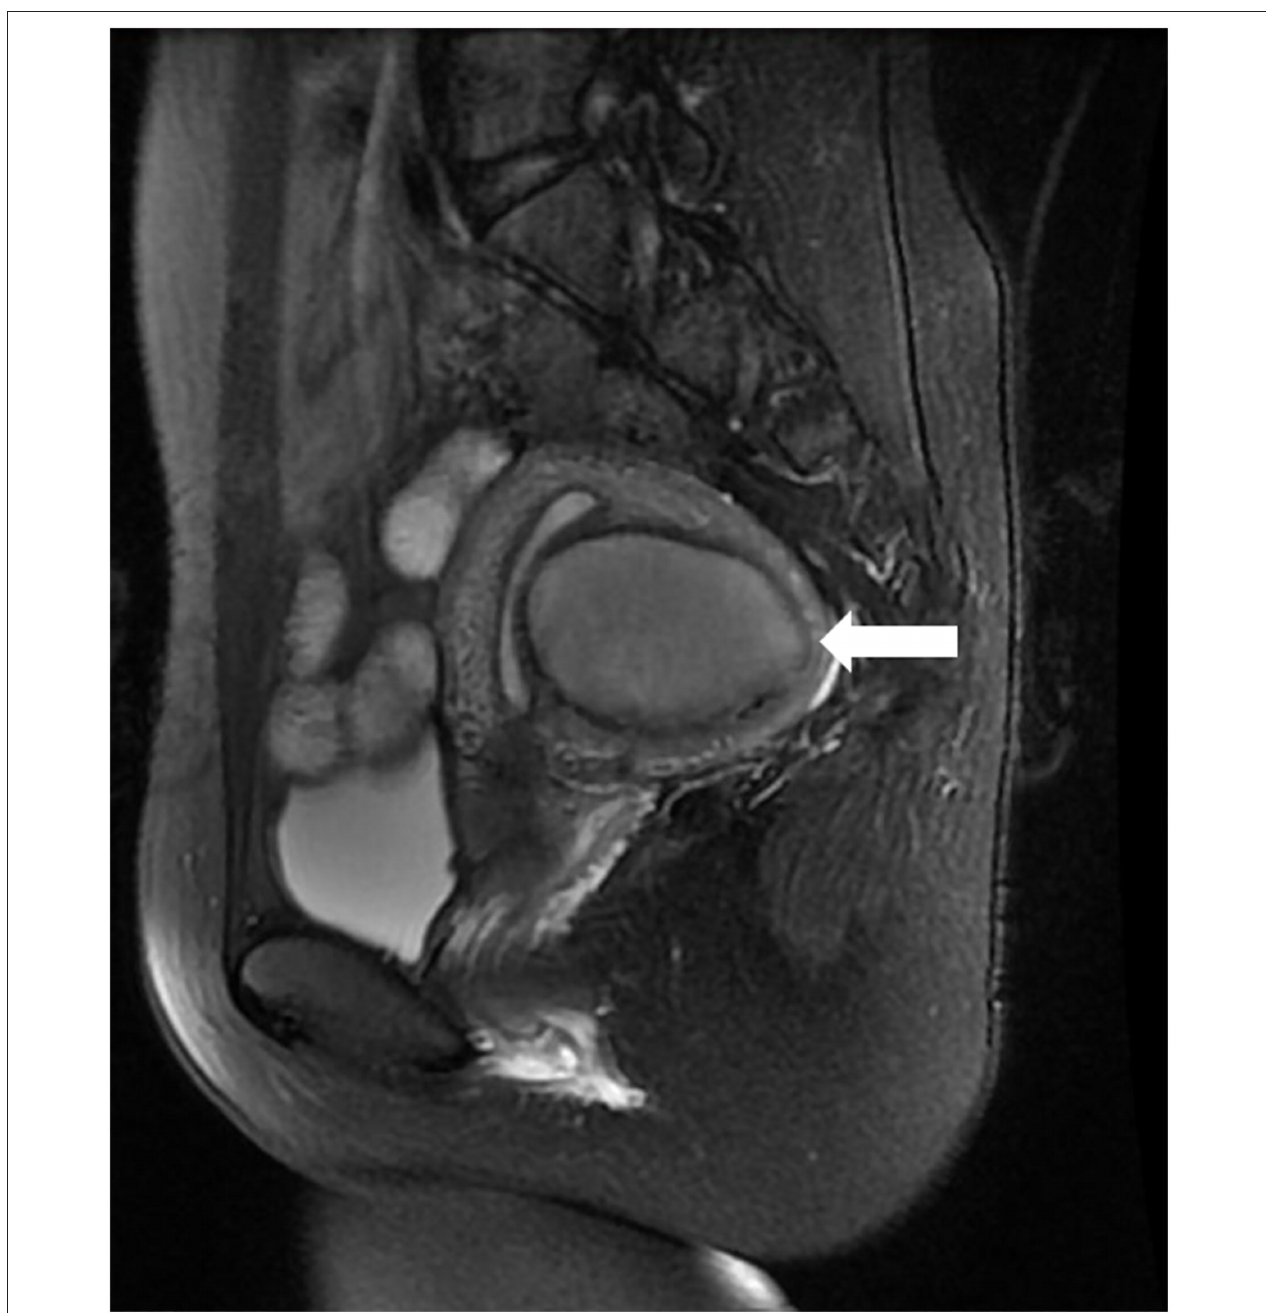
FIGURE 2 | The mass (horizontal arrow) showed hyperintense signal on T-2 weighted Magnetic resonance imaging (MRI) image. It was protruding outward compressing the endometrium but not communicating with the uterine cavity.